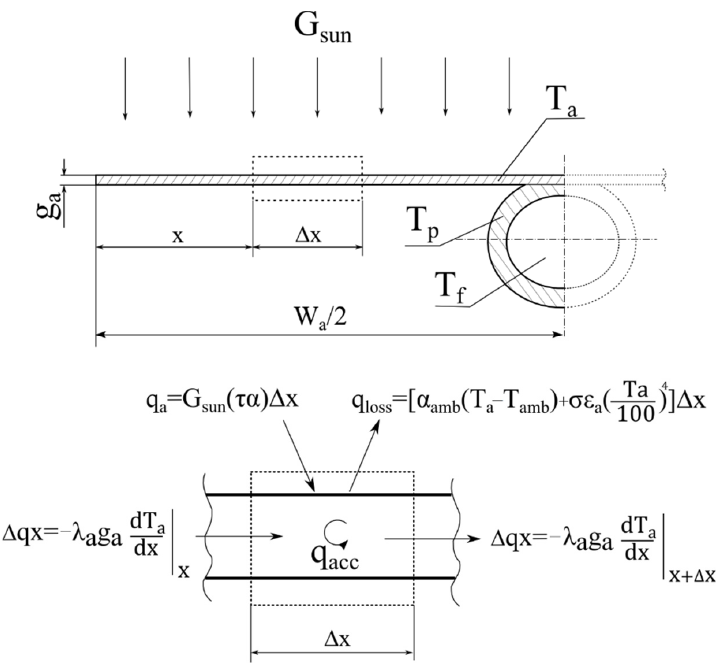
Figure 5. Energy balance of the absorber plate.